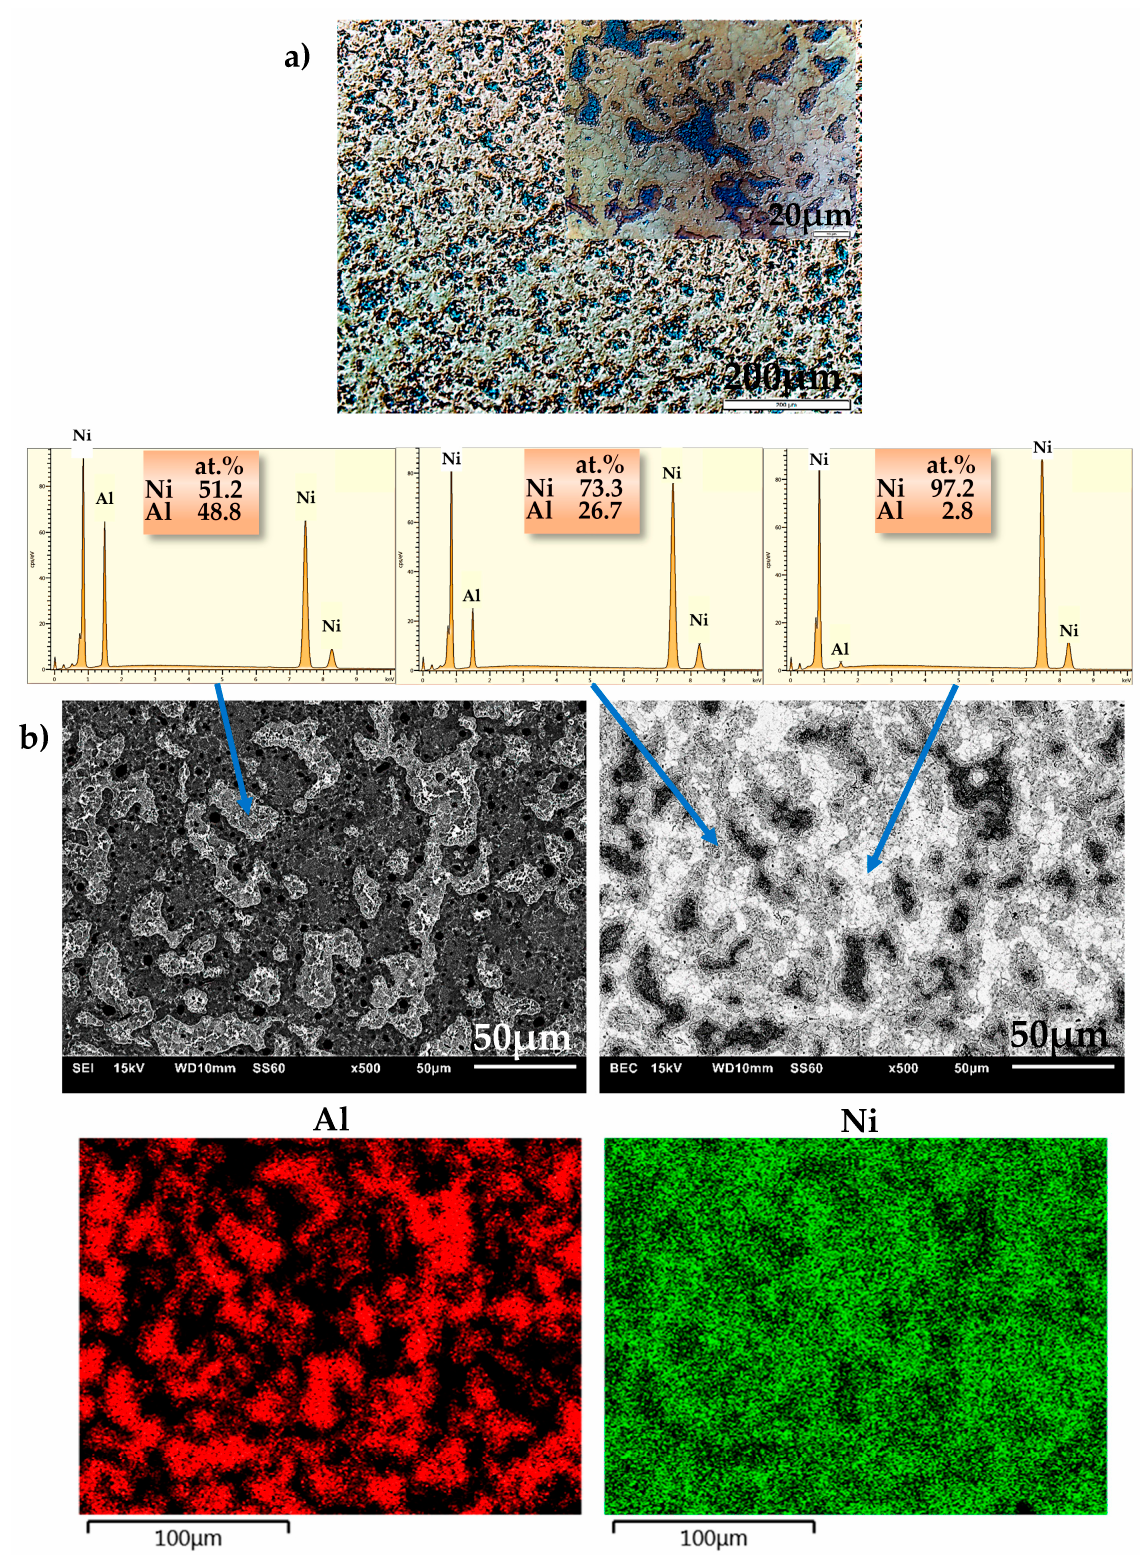
Figure 3. Microstructure of NiAl25 alloy: ( a ) optical microscope, Nomarski contrast; ( b ) SEI—secondary electron image—( left ) and BEC—backscattered electron composition—( right ) SEM micrograph, point-and-map analysis of the distribution of individual microstructural constituents.